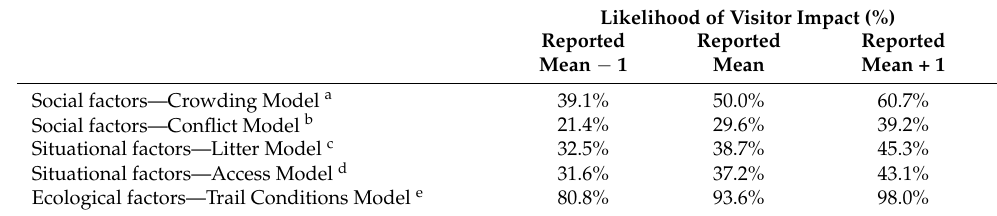
Table 5. Binary Logistic Regression Models—Extrapolations Predicting LBW Visitor Perceptions of